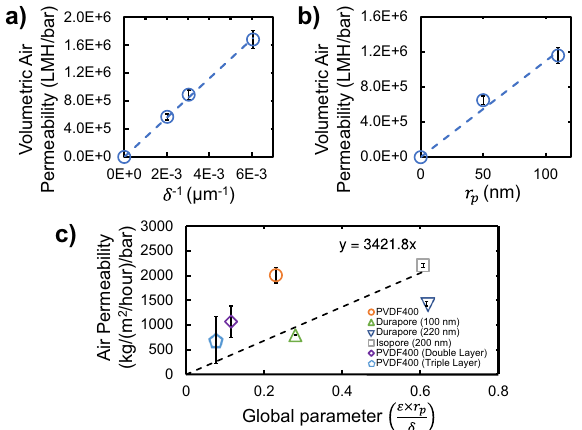
Fig. 2 Membrane air permeability relationship to key membrane parameters. The experimental relationship between dry-air permeability (LMH or liters per m 2 per hour for volumetric, kg per m 2 per hour for mass) and a the inverse of membrane thickness via PVDF400 stacking with no spacing in between membranes to increase thickness (blue circles with blue dashed line) and b pore radius (via Durapore membranes with varying pore size) for water- fi ltration membranes (blue circles with blue dashed line). c Experimentally-determined linear relationship between air permeability and a global parameter for membrane variables (black dashed line). All membranes used displayed hydrophilic behavior (orange circle for PVDF400, green triangle for Durapore-100 nm, dark blue invert pyramid for Durapore-220 nm, gray square for Isopore-200 nm, purple diamond for PVDF400-Double Layer and light blue pentagon for PVDF400-Triple Layer). PVDF400 fl ows are at normal orientation. Data was collected via dry-air- fi ltration (0% relative humidity) using in-line fl ow cell with an area of 9.23 cm 2 . Measured fl ow rate measurements normalized at STP. Error bars represent the standard deviation of 3 different measurements taken on the